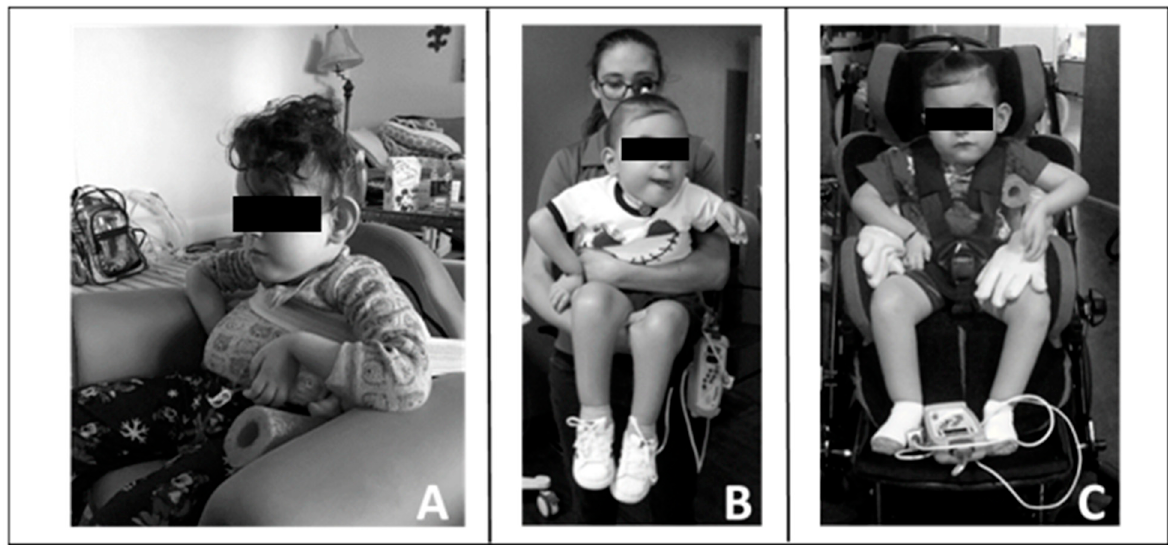
Figure 3. Carry-over of training principles into home and community. ( A ). Modified seat to provide patient with pelvic, lateral, and trunk support. ( B ). Modified carrying position with patient upright allowing for engagement, visual tracking, and head control. ( C ). Modified stroller by bringing patient more upright and added lateral supports to achieve mid-line posture and allow visual engagement and participation.